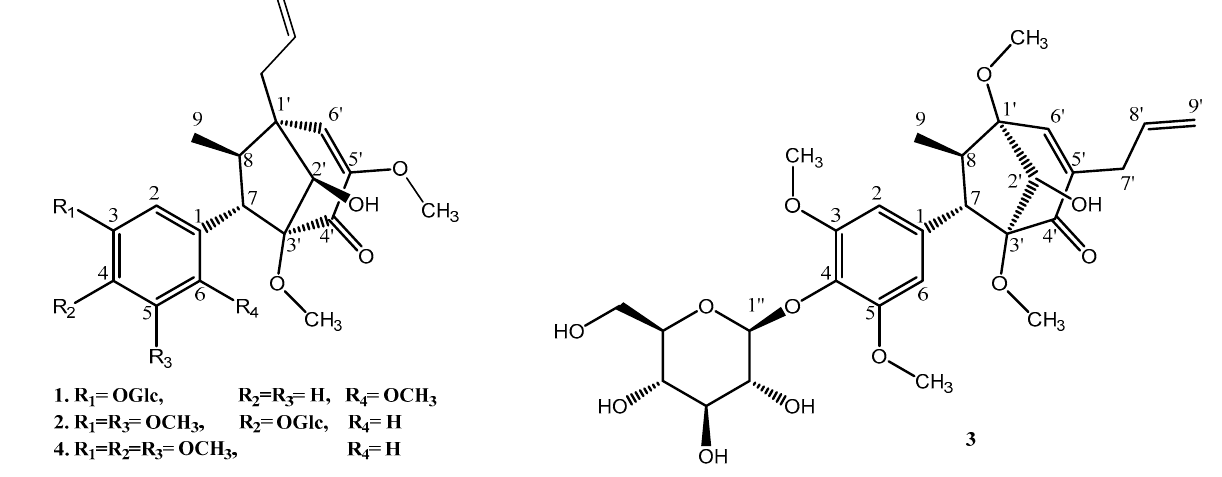
Figure 1. Structures of compounds 1 – 4 from P. crocatum.